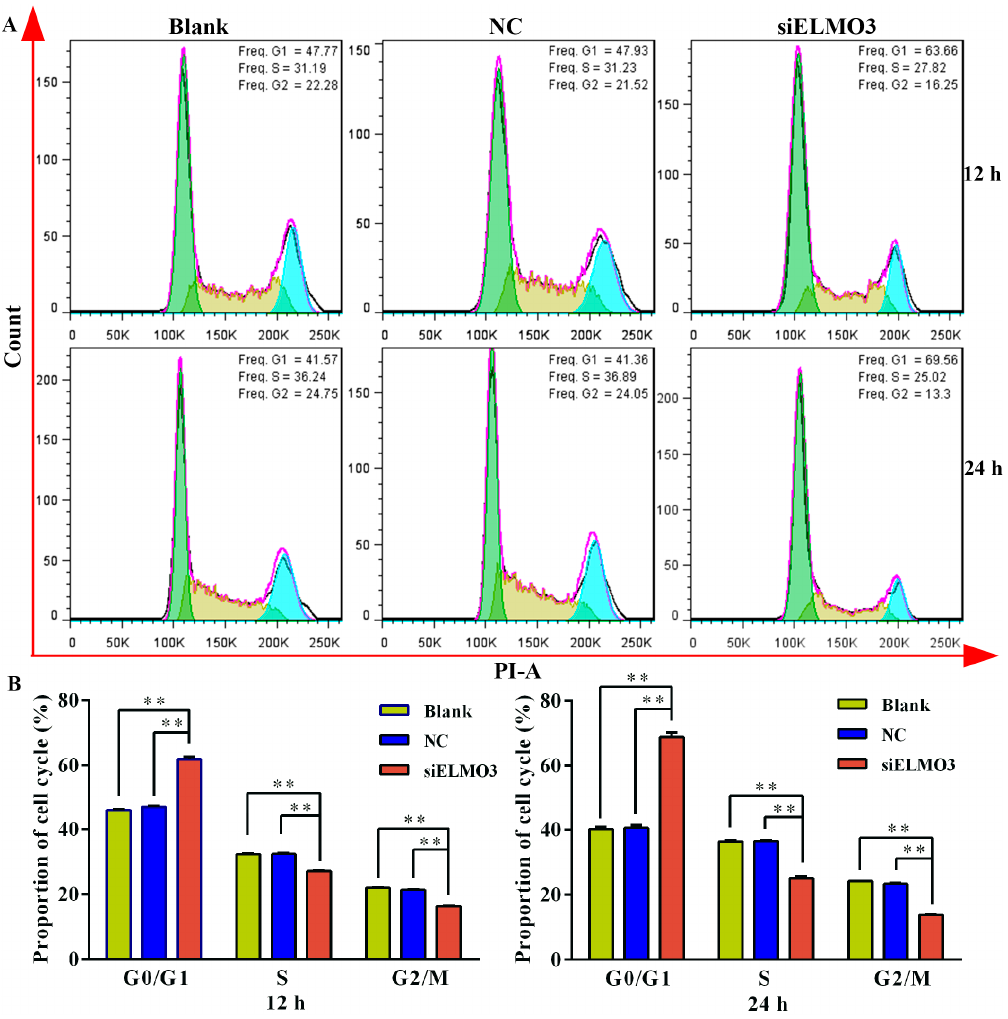
Figure 4. Knockdown of ELMO3 arrested the cell cycle of HCT116 cells at G1 phage. ( A ) The cell cycle distribution of HCT116 cells was detected by flow cytometry and ( B ) Statistical analysis was performed by ANOVA. ** p < 0.01.